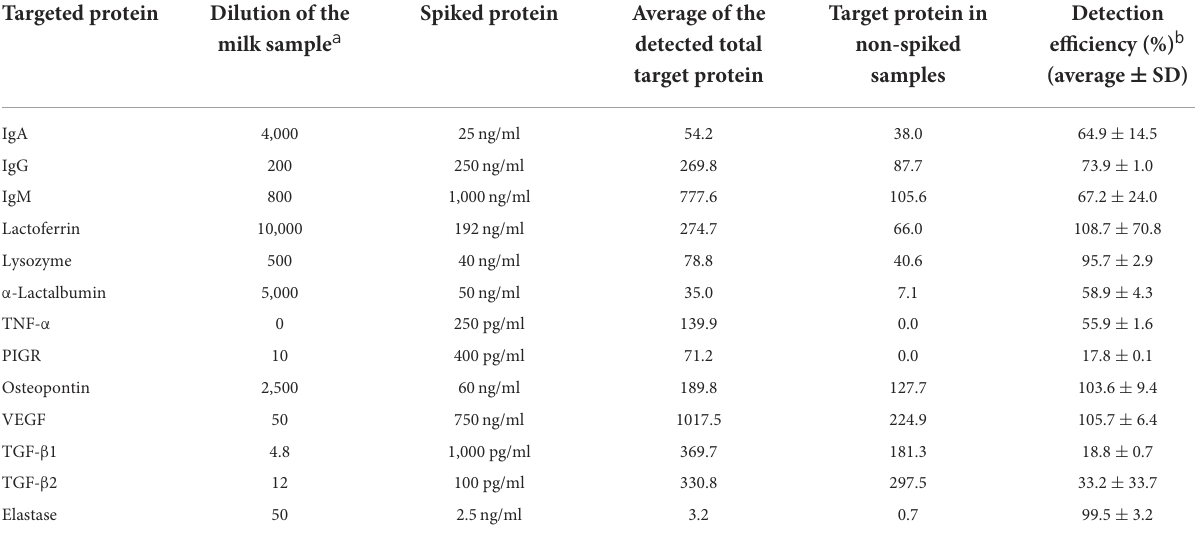
TABLE 1 Detection efficiency (%) of spiked proteins in raw diluted donor human milk. Targeted